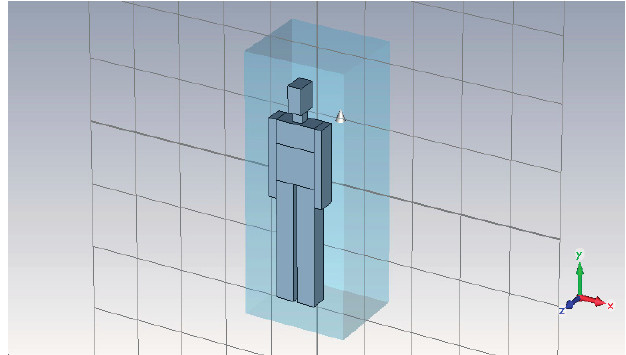
Figure 20. Geometry considered for the calculation of the interfering